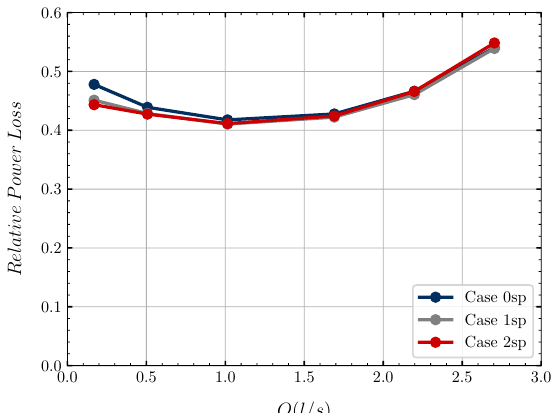
Figure 11. Relative total losses.